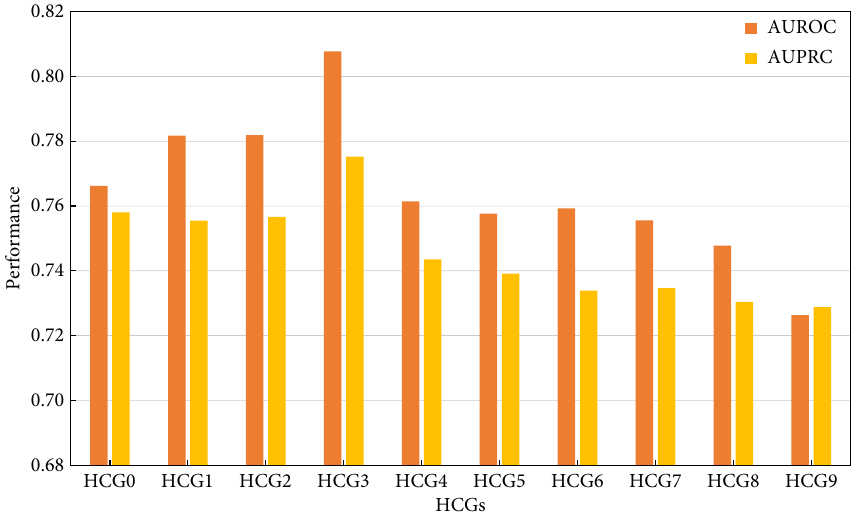
to ensure the presence of at least one link pointing to each vertex.